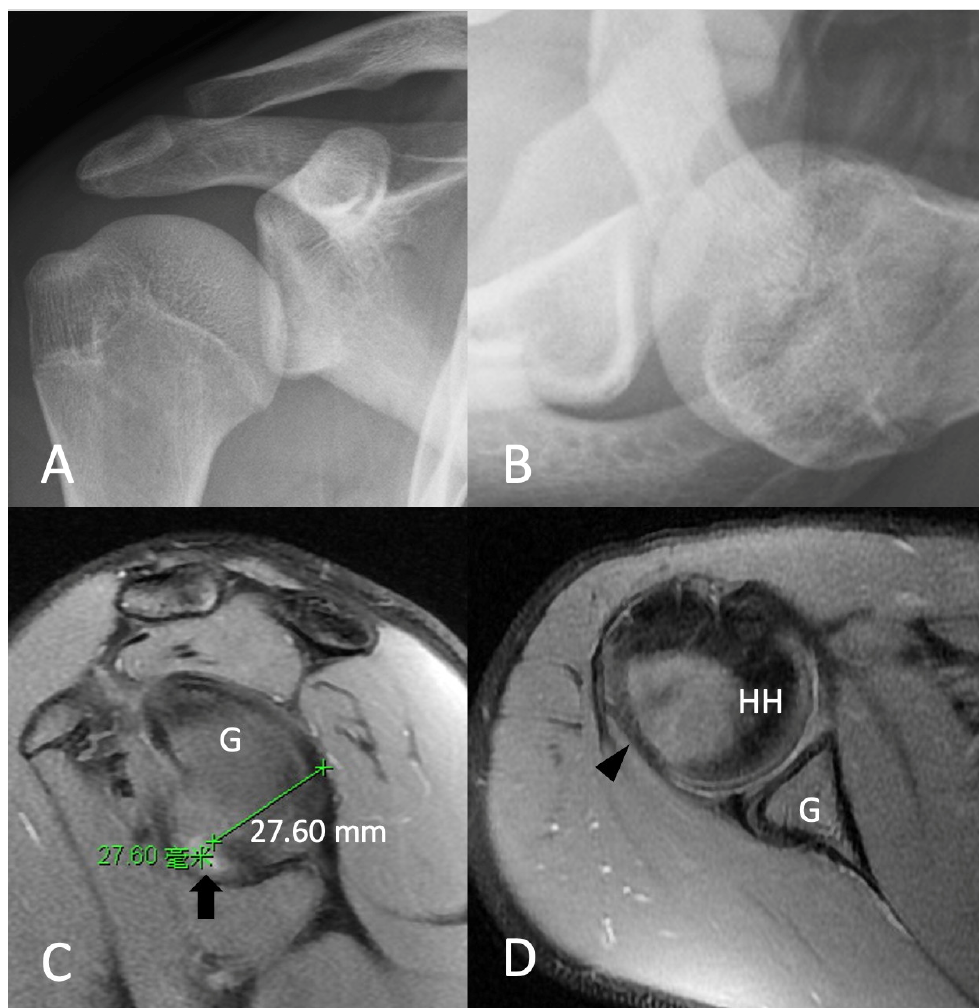
Figure 1. Preoperative X-ray and MRI of right shoulder revealed ( A , B ) no apparent glenoid bony lesion or Hill–Sachs lesion. ( C ) Anterior labroligamentous periosteal sleeve avulsion (arrow) and ( D ) mild posterolateral decompression of humerus head (arrowhead). G, glenoid; HH, humeral head.